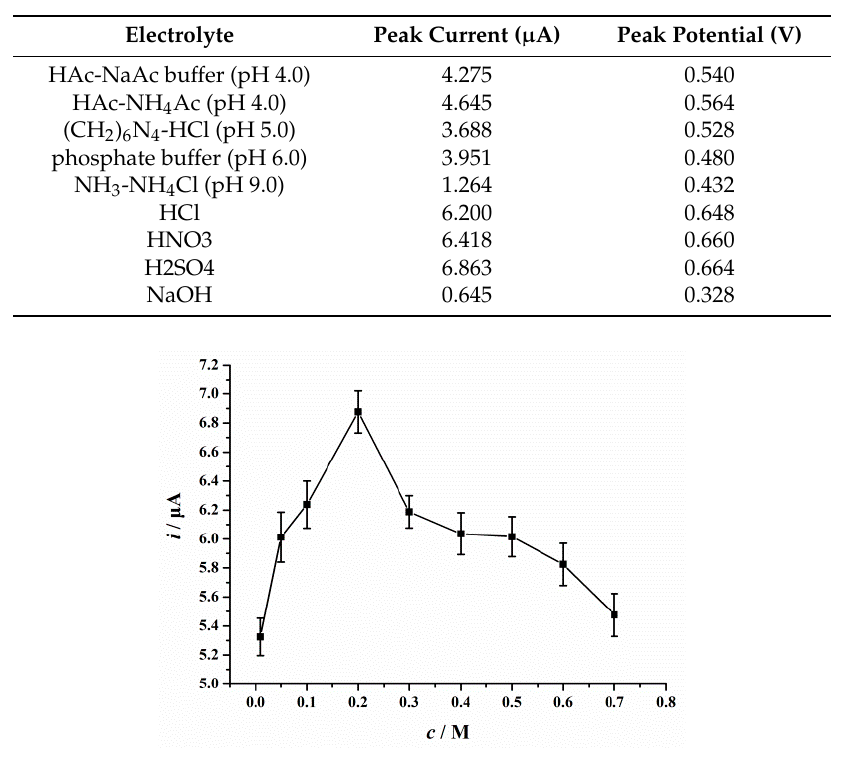
Figure 7. The dependence relationship of the peak current of 10 µ M rutin and H 2 SO 4 concentration by SDLSV, error bars represent SD, n = 3. Accumulation potential: − 0.3 V, accumulation time: 30 s, scan rate of 0.1 V/s.